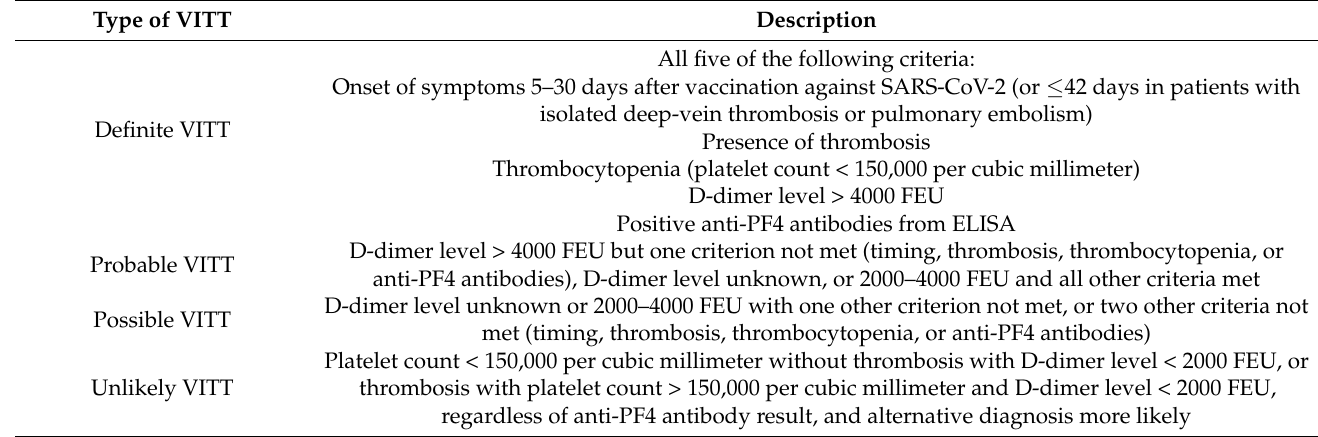
Table 2. Case Definition Criteria for Vaccine-Induced Immune Thrombocytopenia and Thrombosis (VITT), According to an Expert Hematology Panel. Pavord S. et al. [23].